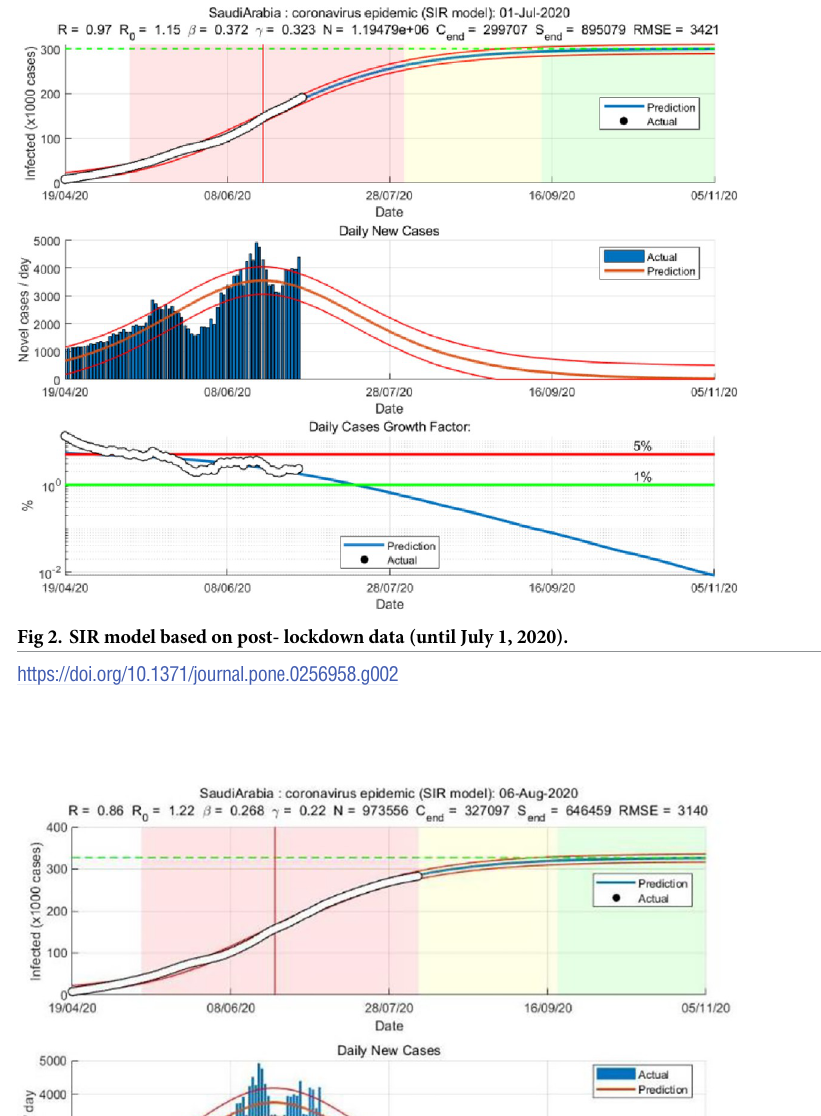
PLOS ONE | https://doi.org/10.1371/journal.pone.0256958 September 9,